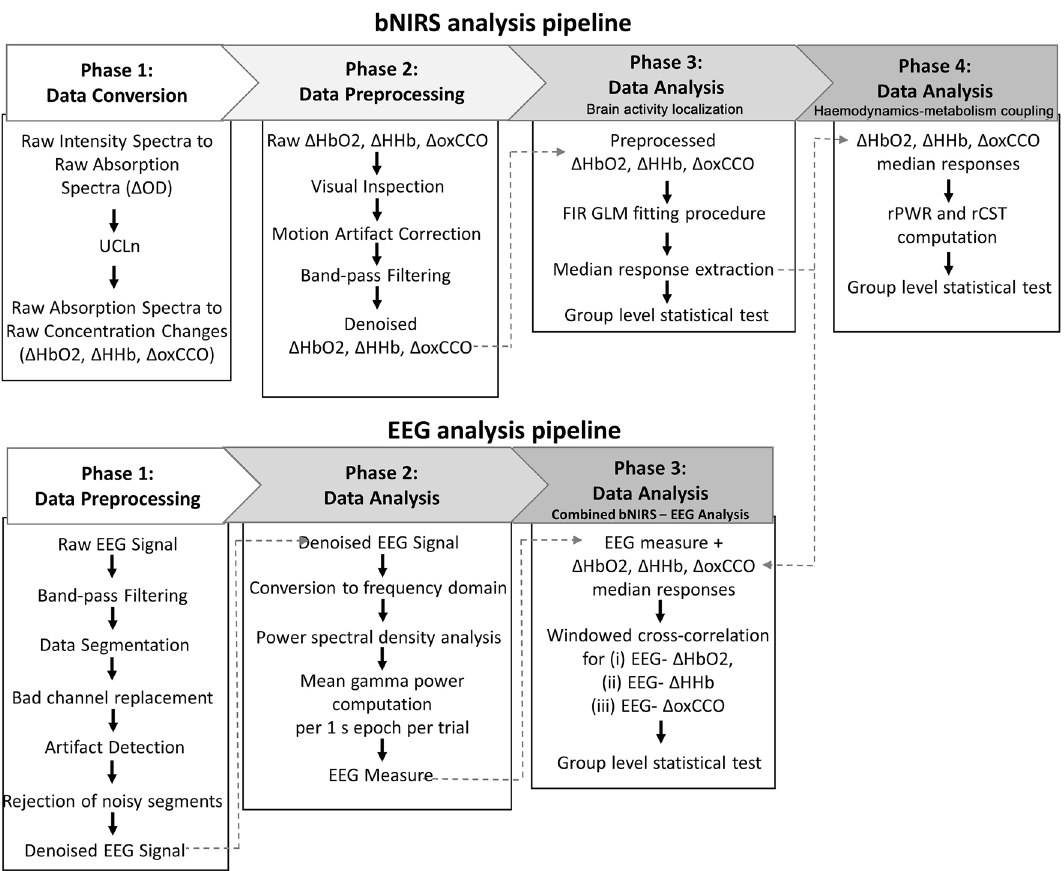
Figure 10. Flow chart of the data analysis pipeline for bNIRS (top) and EEG